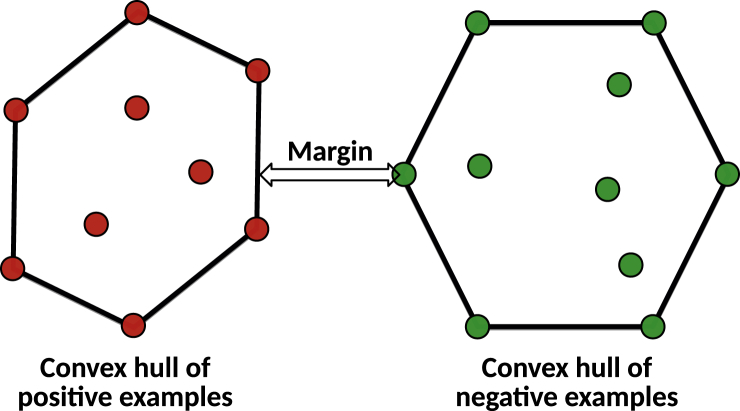
The margin is the distance between the convex hull of the positive examples (in red) and the convex hull of the negative examples (in green). EasyMKL is able to find a combination of kernels that maximizes this distance.